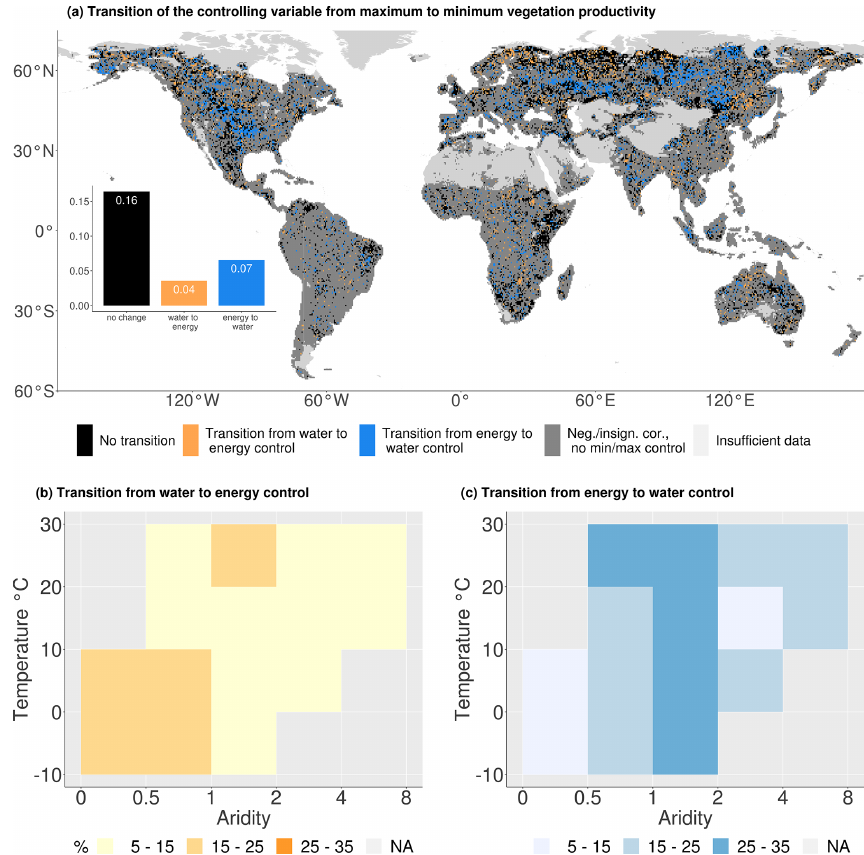
Figure 6. Changing hydrometeorological controls between vegetation productivity maxima and minima. (a) Global distribution of changing controls: in panels (b) and (c) grid cells are binned by their long-term climate characteristics. Panel (b) indicates the percentage of grid cells in each climate regime switching from water to energy control; panel (c) denotes the percentage of grid cells changing from an energy-controlled maxima to a water-controlled